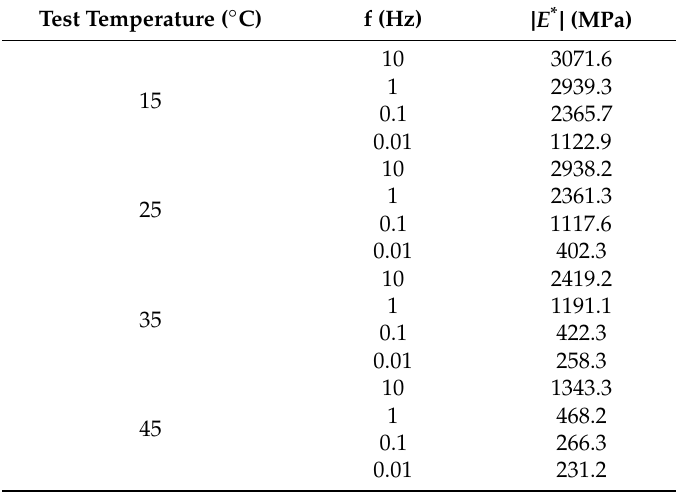
Table 7. Dynamic modulus of AC-WC asphalt mixture at a reference temperature 25 ◦ C (with | E ∗ | max